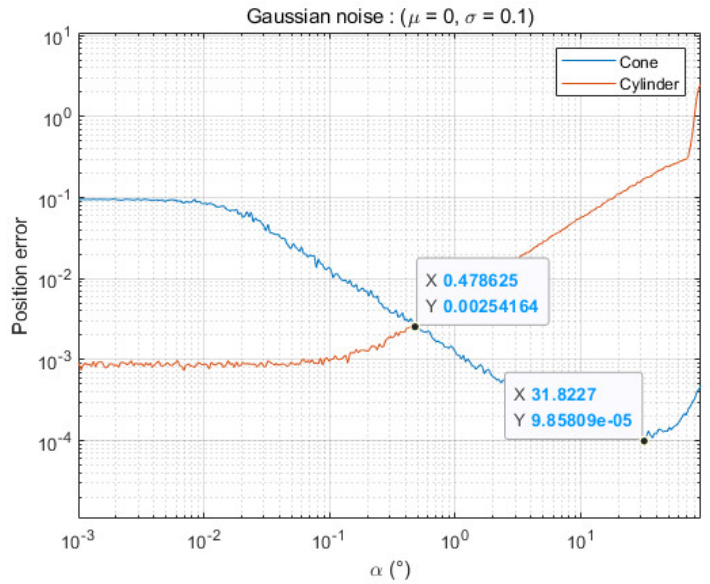
Figure 11. Results of the simulation according to the angle α